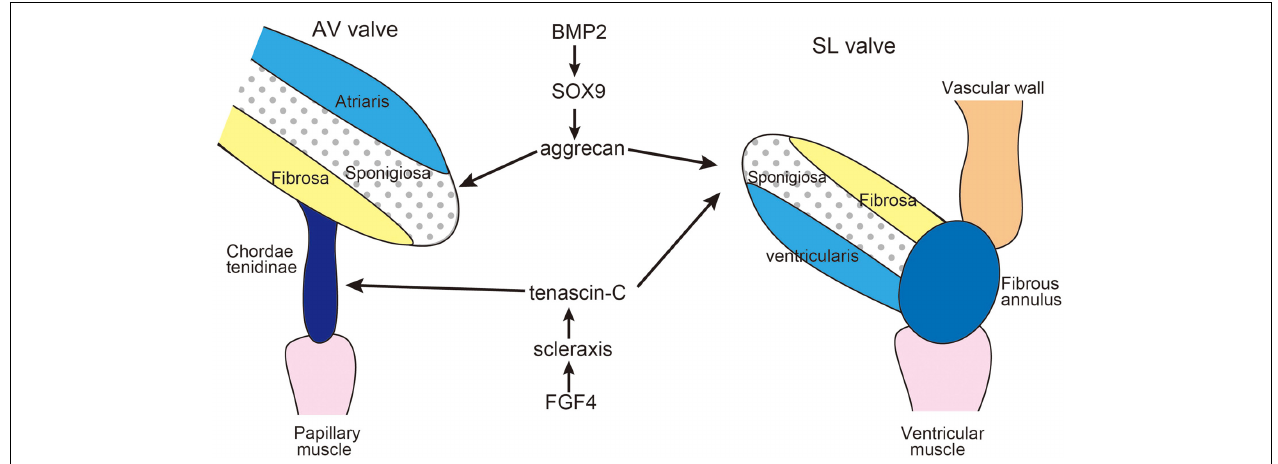
FIGURE 2 | Diagram of extracellular matrix compartmentalization of the mature AV and SL valves. During valve maturation, BMP2 signaling induces cartilage-associated genes Sox9 and aggrecan, while FGF4 signaling promotes